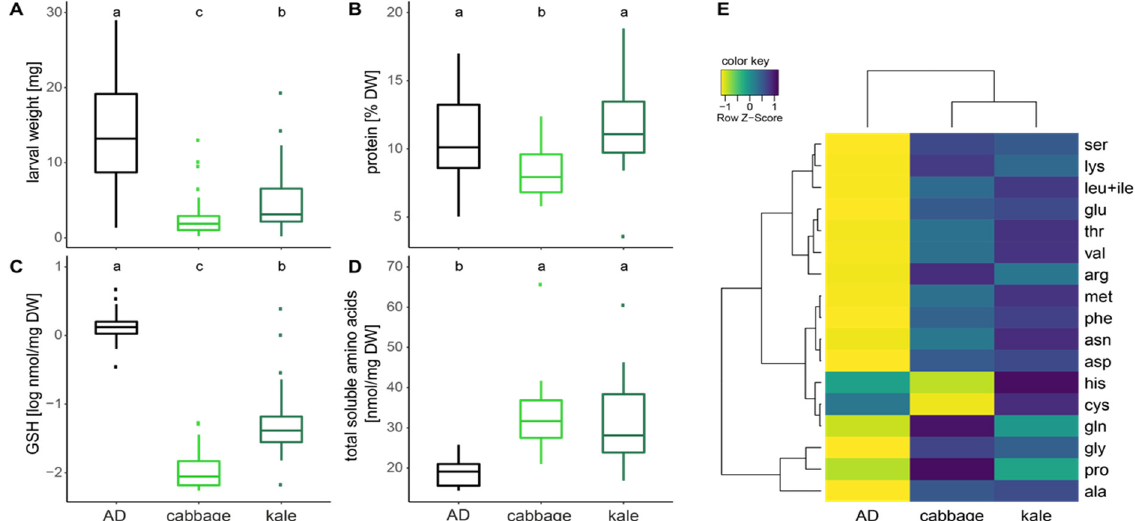
Figure 2. Larval weight and body nutritional composition when fed on artificial diet and food plants with different GSL contents. ( A ) Larval fresh weight at 4–5 days (III instar) in mg ( p < 0.001, n = 80–152); Figure S2 depicts the corresponding values for dry weight. ( B ) Protein in % of dry weight ( p = 0.001, n = 20); ( C ) GSH concentrations in log of nmol/mg dry weight ( p < 0.001, n = 20); ( D ) Total soluble amino acids in nmol/mg dry weight ( p < 0.001, n = 20); ( E ) Heatmap of the mean [nmol/mg DW] of detected soluble amino acids, with yellow to green corresponding to small values and green-blue to dark blue to high values. Data were scaled across rows, comparing amounts of these amino acids between diet treatment groups. Statistical differences for A-D were assessed using a nested ANOVA mixed affect model, letters denote statistical difference at p = 0.05 level tested with Tukey post hoc test. Means, standard deviations and statistical details for A-D and individual amino acids ( E ) are in Table S2. AD, artificial diet; DW, dry weight; ▪ indicate outliers in the box-and-whiskers plots.